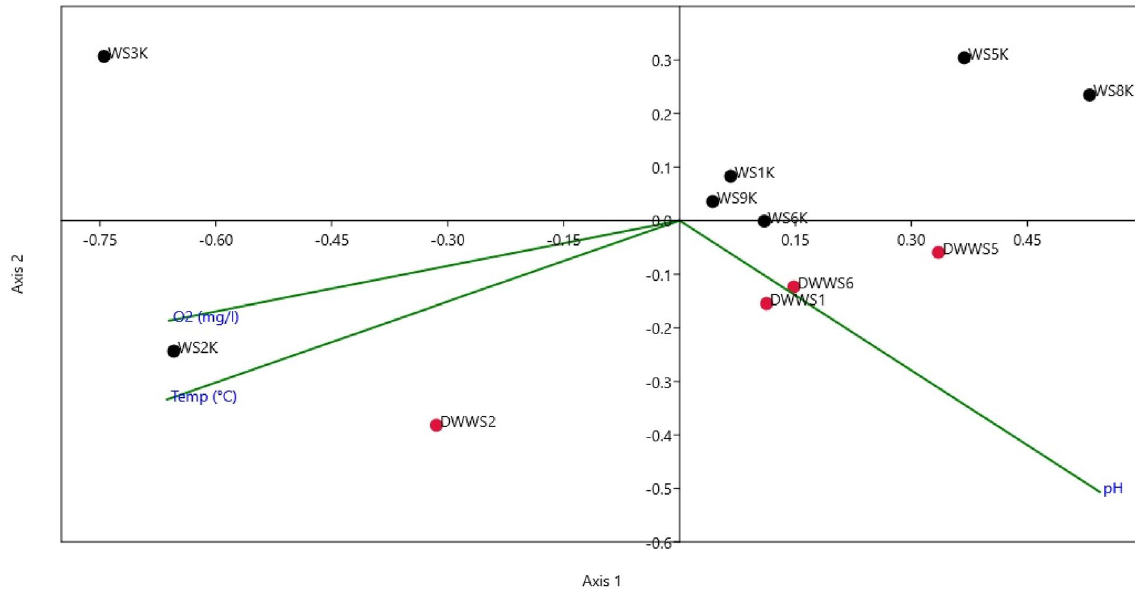
Figure 4. CCA result of directly studied water (DWWS1–DWWS6, red circles) and sediment (WS1K–WS9K, black circles) with environmental variables temperature, pH and dissolved oxygen concentrations at sampling locations in Lake Van (The figure was created using the PAST software package version